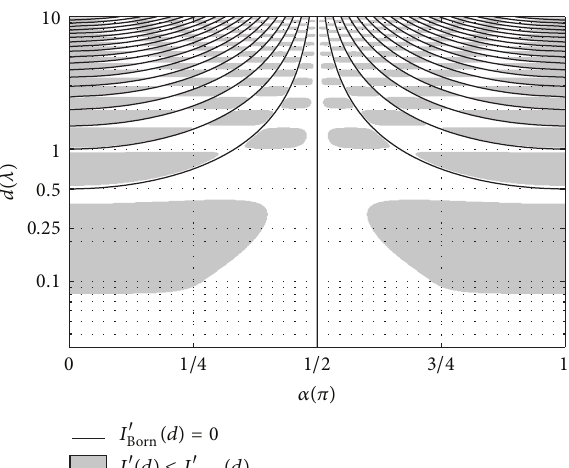
Figure6:Mapoftheregionswheremultiplescatteringeffectsdonot aid the estimation of target separation in relation to blind conditions of the Born approximation model. Black lines mark conditions (𝑑) = 0 . Gray areas mark regions where 𝐼 󸀠 (𝑑) ≤ 𝐼 󸀠 where 𝐼 󸀠 Born The same parameters are used here as in Figure 4 ( 𝜏 1 = 𝜏 2 = 1 , 𝛽 = 𝜋 − 𝛼 , 𝑑 𝑐 is known).